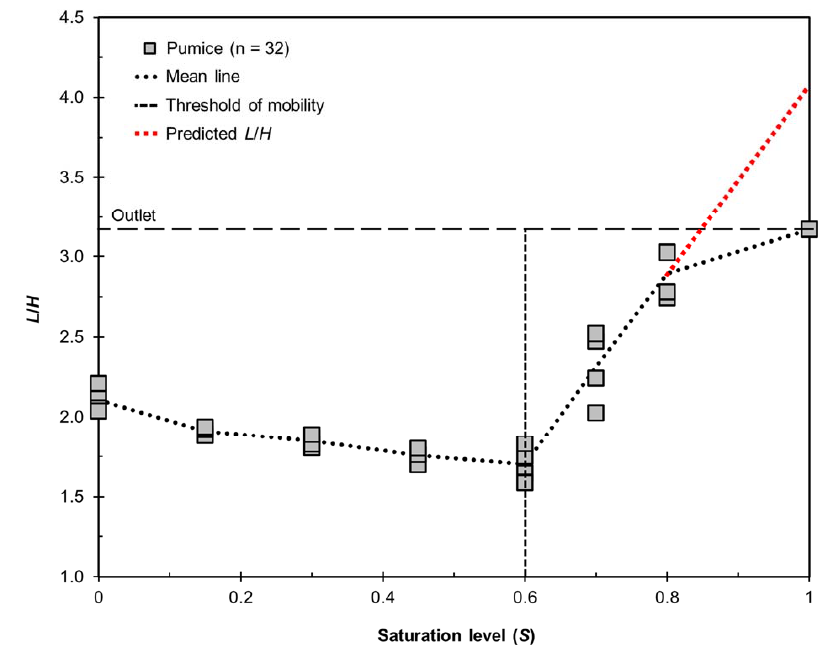
Figure 4. The L / H of pumice for various saturation levels. X-axis shows saturation levels ( S ), where S = 0 represents completely dry conditions, whereas S = 1 represents completely saturated conditions. Y-axis shows L / H , the ratio between total travel distance ( L , cm) and total drop height ( H , cm) of sediment. Both S and L / H are dimensionless parameters. Water 2022 , 14 , x FOR PEER REVIEW